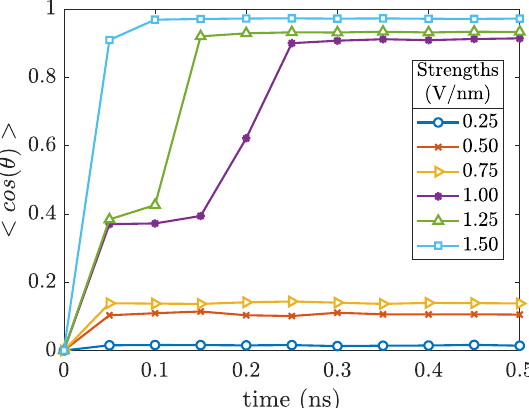
Figure 4. Change in < cos ( θ ) > vs. time upon application of e-field on the initially α -glycine crystal. E-field was applied in the y-direction with strengths changing between 0.25 and 1.5 V/nm.